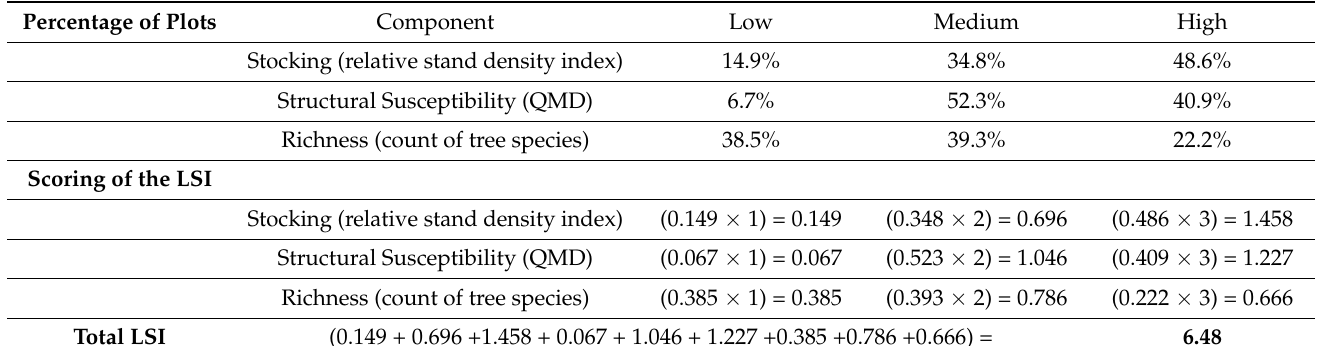
Table 4. Example calculation of the LSI for Colorado ( n = 3656) across the three component classes. First, the percent of each component on the landscape is calculated and then scored to allow for the summation of the total. It should be noted that the total of the percentages may not add to zero due to unstocked stands. The total LSI ranges from 3 to 9, with 3 being the lowest susceptibility and 9 the highest. By incorporating a percentage approach, the LSI is saleable and comparable (see Table 5 for